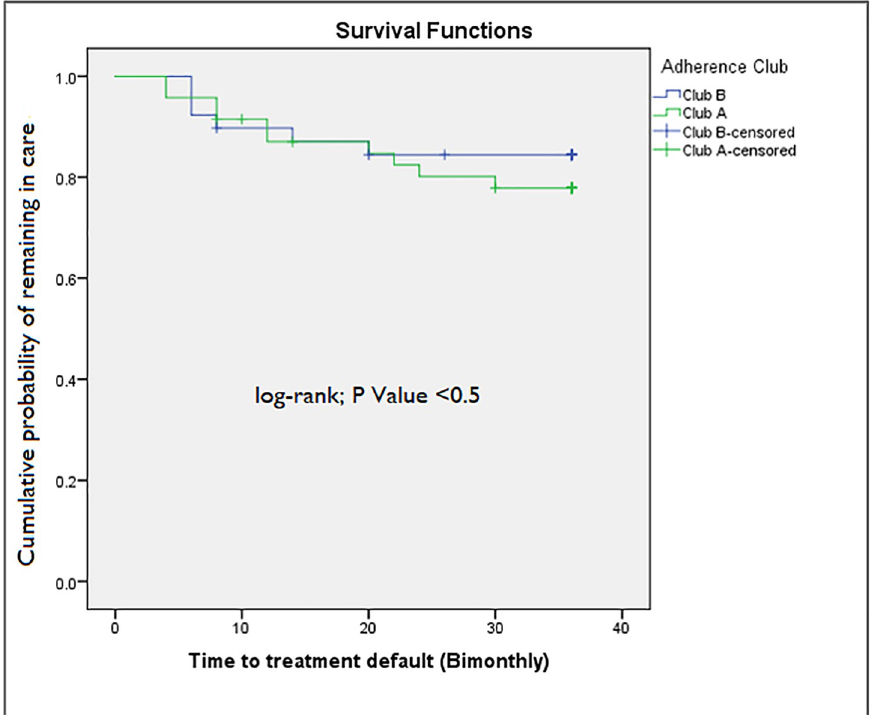
Fig 4. Cumulative probability of patients remaining in care in adherence Clubs A and